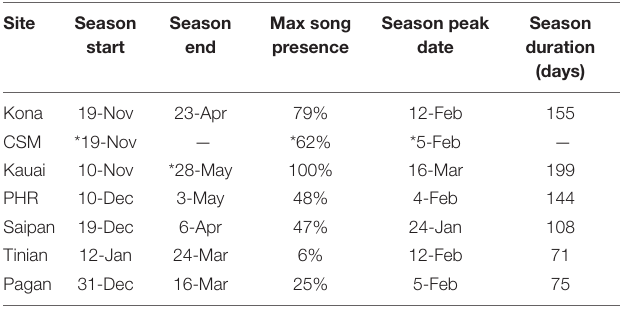
TABLE 3 | Summarized season data for the recording sites with seasonal humpback